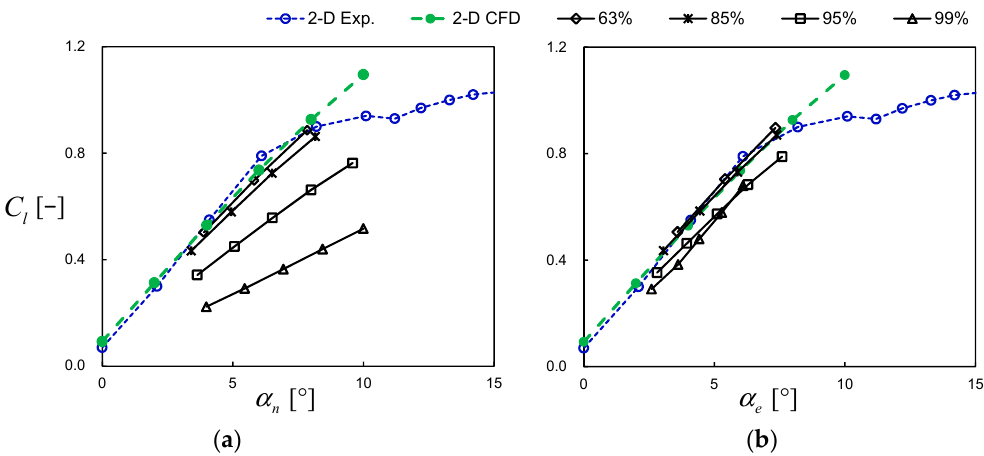
Figure 16. Lift coefficient extracted through: ( a ) nominal AoA; ( b ) effective AoA. Figure 16. Lift coe ffi cient extracted through: ( a ) nominal AoA; ( b ) e ff ective AoA.